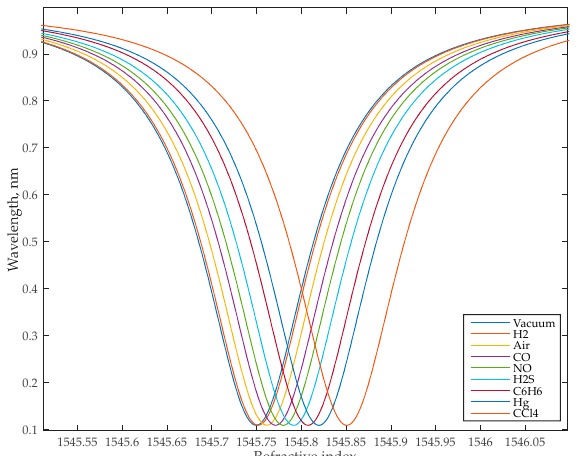
Figure 5. Transmission spectra of the add-drop MRR sensor for different ambient gases.